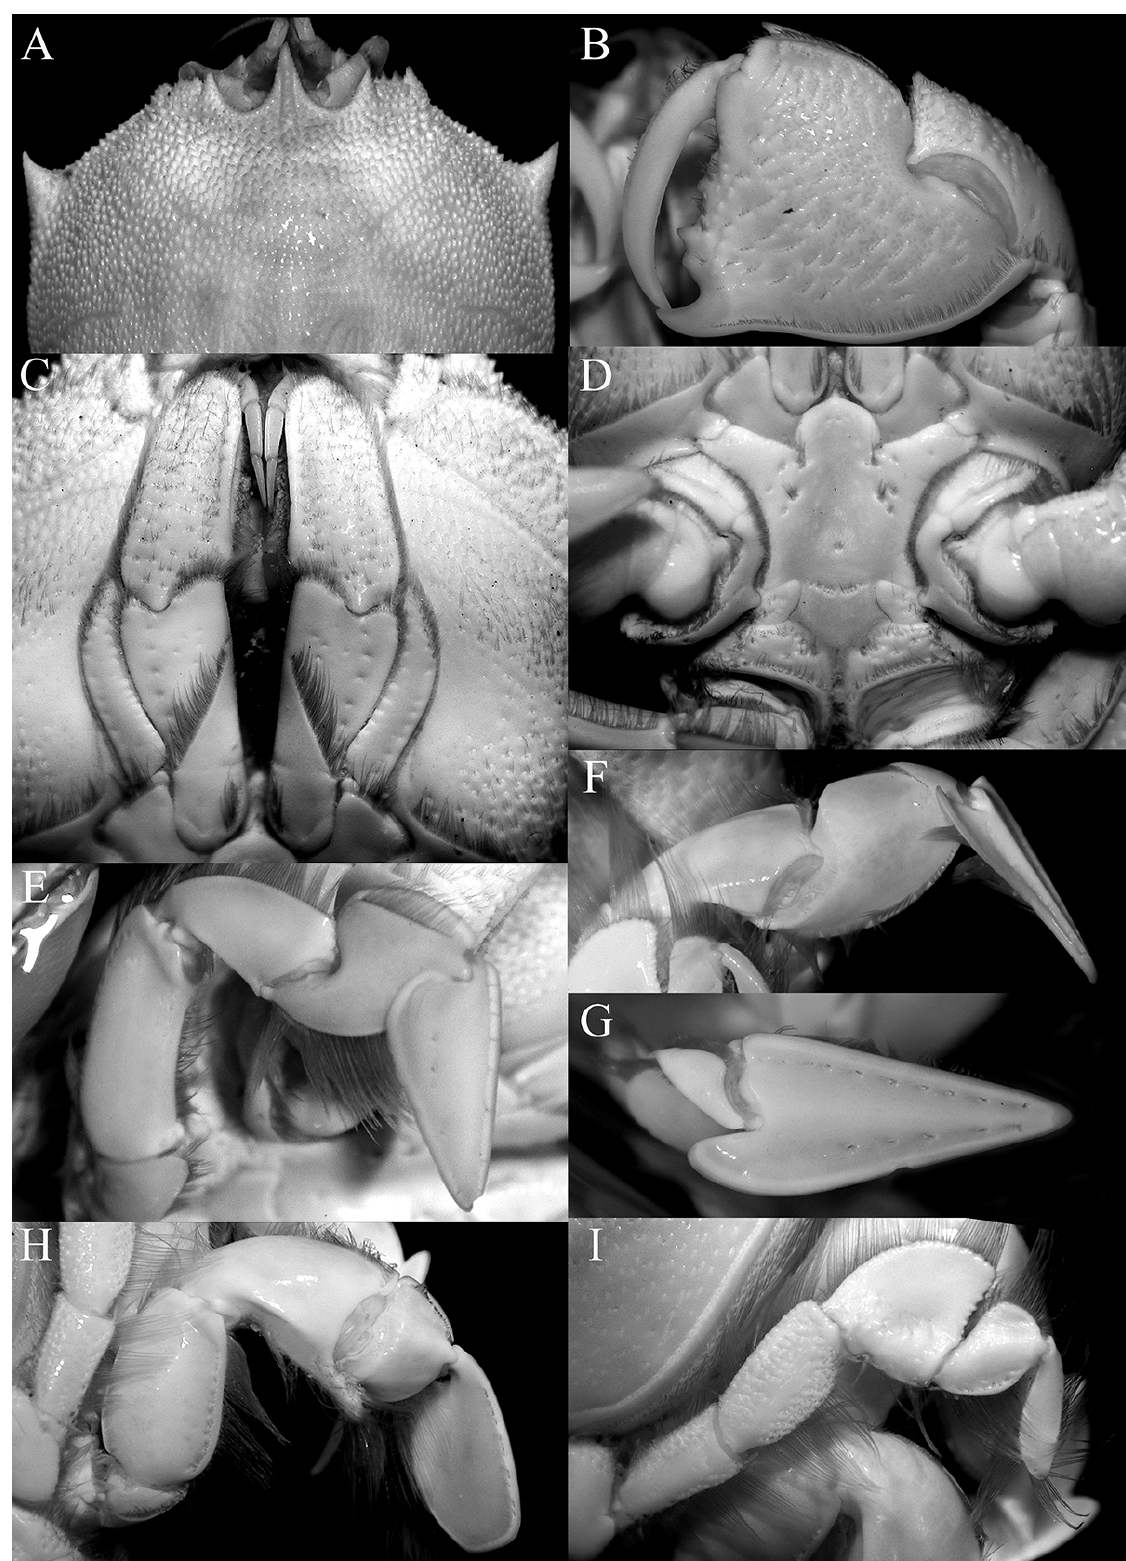
Figure 2. Umalia trirufomaculata , holotype male (20.4 x 26.3 mm) (WAM 348-60), Western Australia. A, anterior part of carapace showing front; B, outer view of left chela; C, third maxillipeds; D, anterior thoracic sternum; E, first ambulatory leg; F, carpus, propodus and dactylus of second ambulatory leg; G, marginal view of dactyus of second ambulatory leg; H, third ambulatory leg; I, right fourth ambulatory